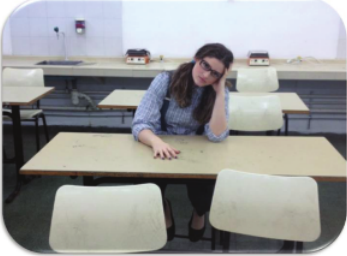
Figure 2: A hindering photonarrative “difficulty in sympathizing.”